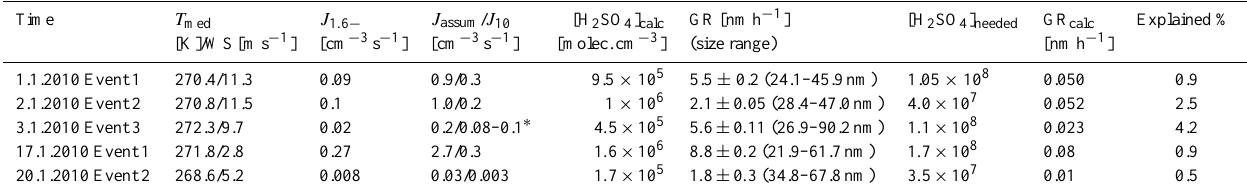
Table 1. Obtained and calculated parameters for selected NPF events during 1 to 3 and 17 to 20 January 2010. T med is the median temperature over the event time, WS is the wind speed at the onset of visible nucleation, J 1 . 6 − is the formation rate of 1.6-nm sized negative clusters and J assum is the nucleation rate assuming that the ion-induced nucleation explains 10% of the observed. K , which is the coefficient in Eq. (1), is assumed to be 10 − 12 cm − 3 s − 1 . [H 2 SO 4 ] calc is the calculated atmospheric sulphuric acid concentration whereas [H 2 SO 4 ] needed is the sulphuric acid concentration needed to explain the growth without organics. GR calc is the GR that would result from the atmospheric sulphuric acid concentration and GR is the growth rate obtained from DMPS size spectrum using the “mode-fitting method” described in Dal Maso et al. (2005); Yli-Juuti et al. (2011). Also, the percentage that sulphuric acid explains of the growth is given. Event numbers refer to the ones marked in Figs. 3 and